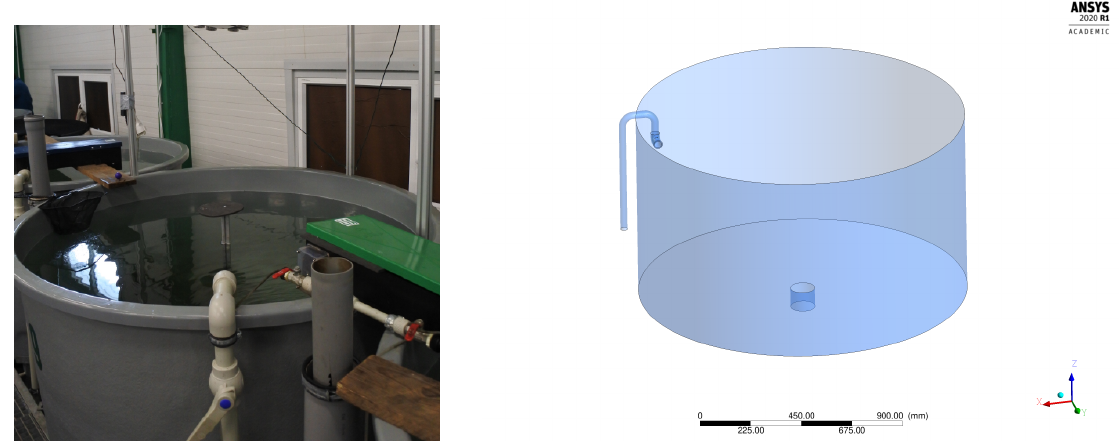
Figure 1. ( left ) Illustration picture of the fish tank operated at the Research Institute of Fish Culture and Hydrobiology, University of South Bohemia in ˇCeské Budˇejovice. ( right ) Tank geometry generated in ANSYS CFD software